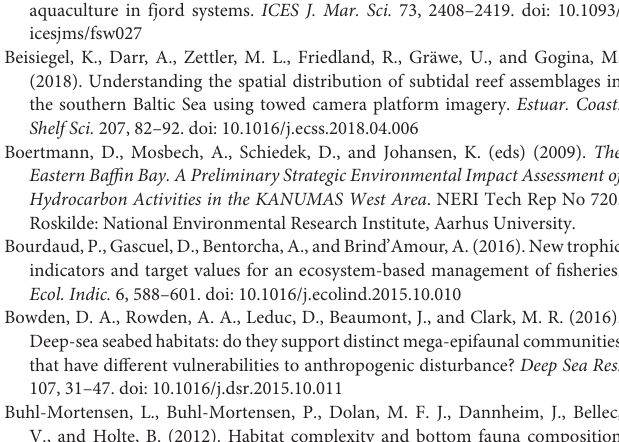
Supplementary Table 5 | DISTLM modeling results to determine the correlations between epifaunal community composition and the environmental variables; coverage of the eight substrate types, seafloor slope and current